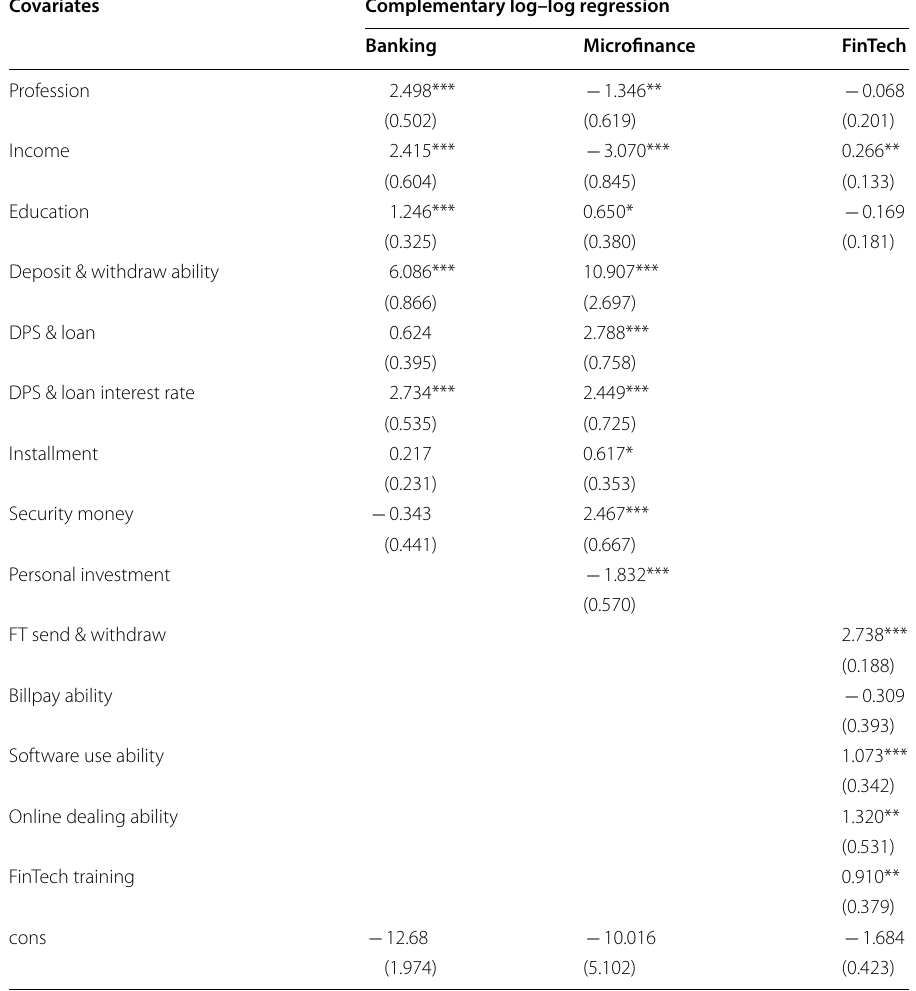
Table 9 Robustness checking with complementary log–log regression. Source : Authors’